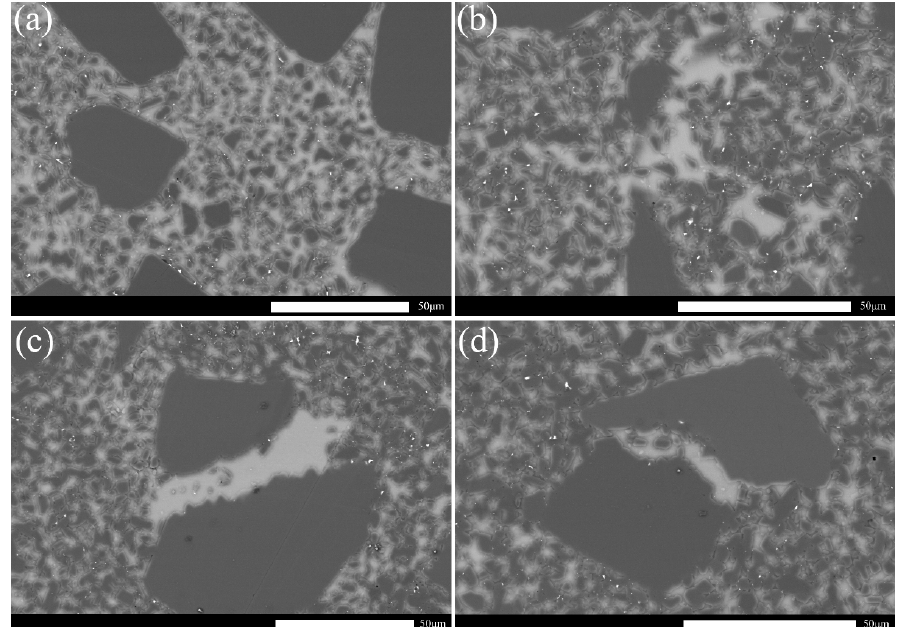
Figure 8. SEM micrographs of the polished surface of the RBSC with different carbon content ( a ) 4 wt%CB, ( b ) 6 wt%CB, ( c ) 8 wt%CB and ( d ) 10